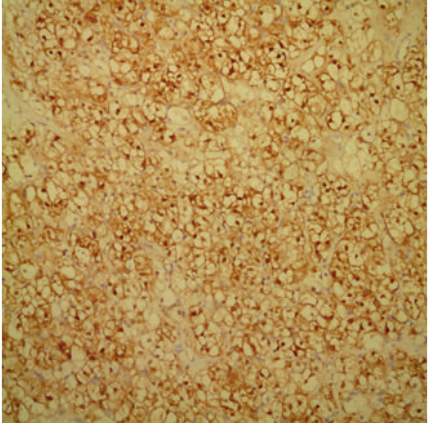
Figure 4: Diffuse cytoplasmic and nuclear positivity with calretinin immunostaining ( ×